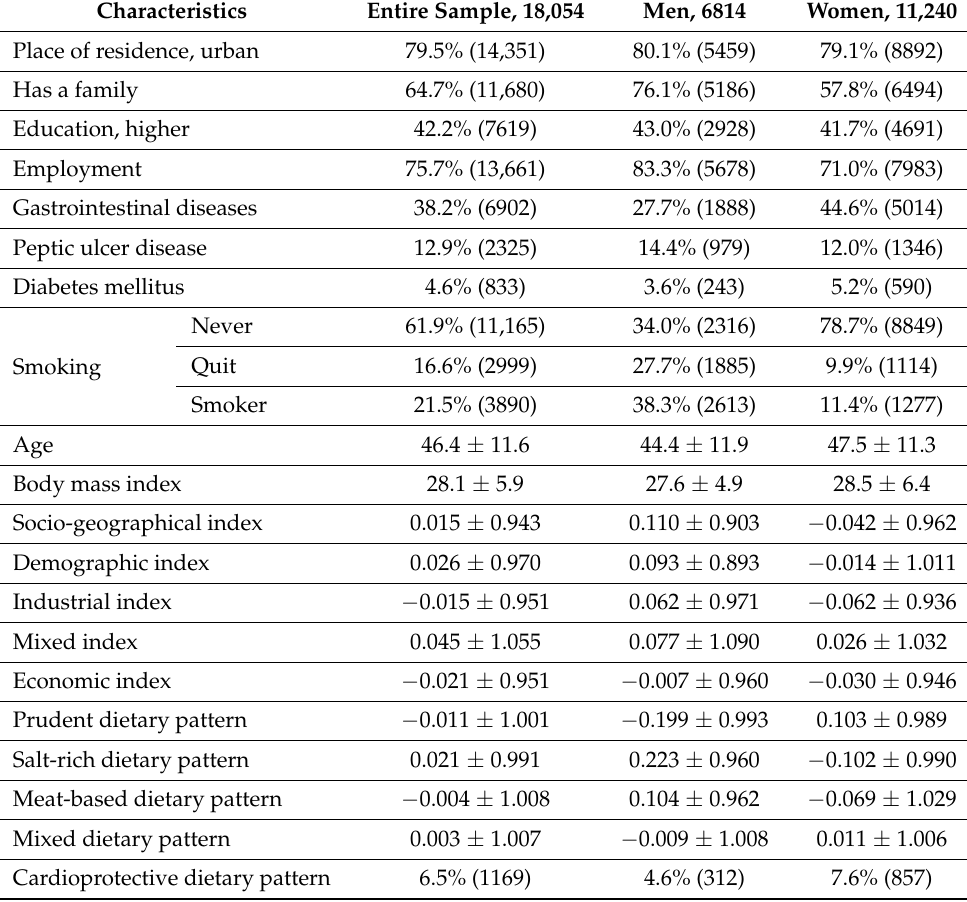
Table 1. Main characteristics of the study